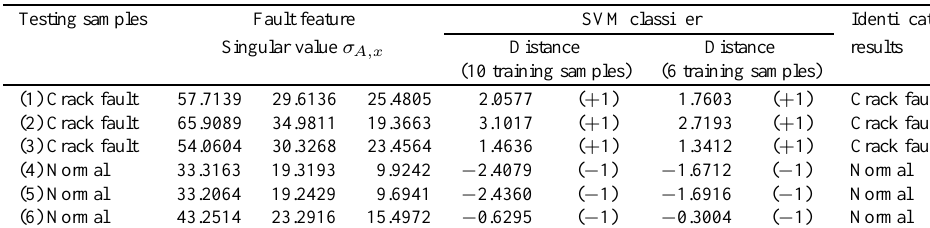
Table 1 The identification results of proposed method for gear